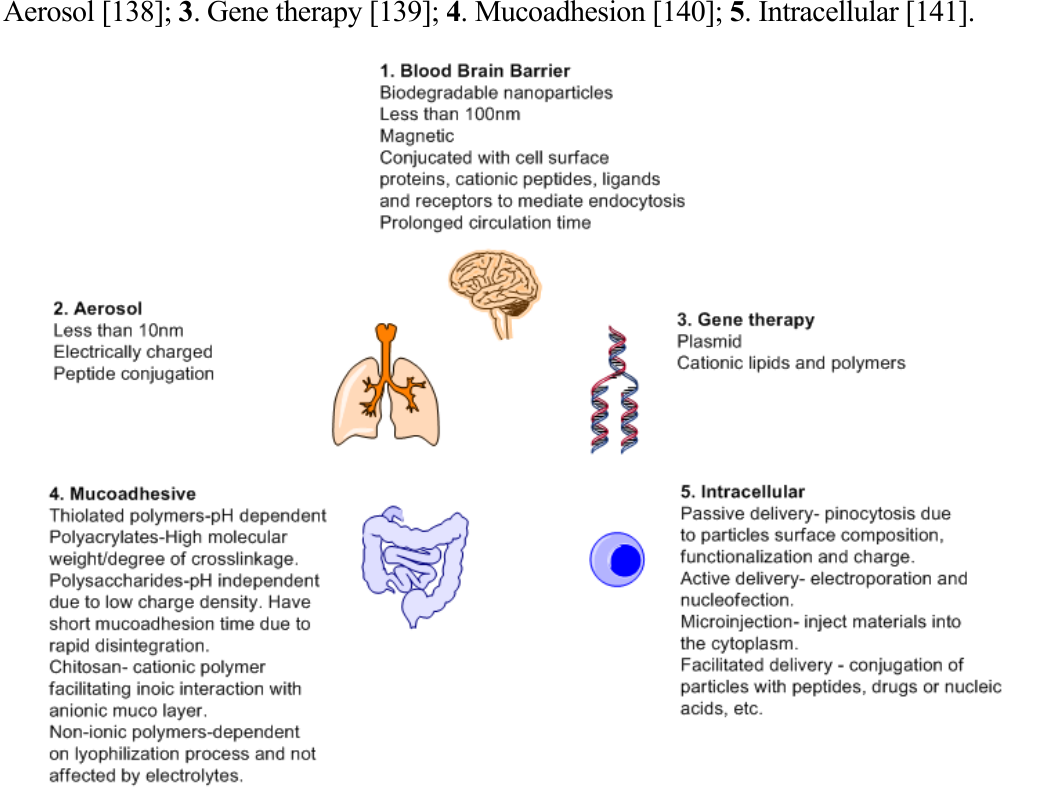
Figure 11. Nanoparticles as target specific drug delivery system. 1 . Blood brain barrier